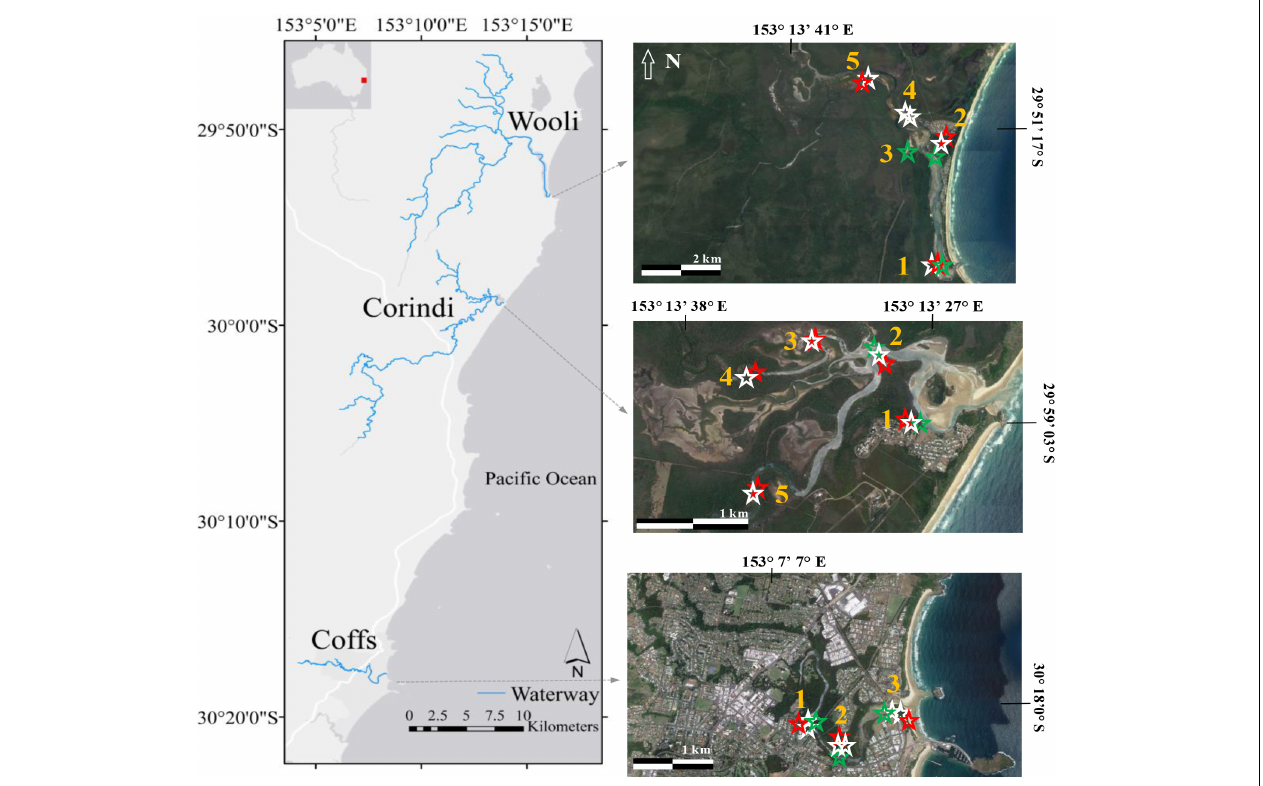
FIGURE 1 | Study region on the left, and satellite image of each estuary on the right. The townships of Coffs Harbour, Corindi Beach and Wooli, NSW [populations: 72,971, 1,200, and 418, respectively (ABS, 2016)]. Coffs Harbour is the main urban center of the region. Numbers on the satellite image of each area indicate location of sediment samples, greens stars represent seagrass, white stars mangrove and red stars saltmarsh sediment